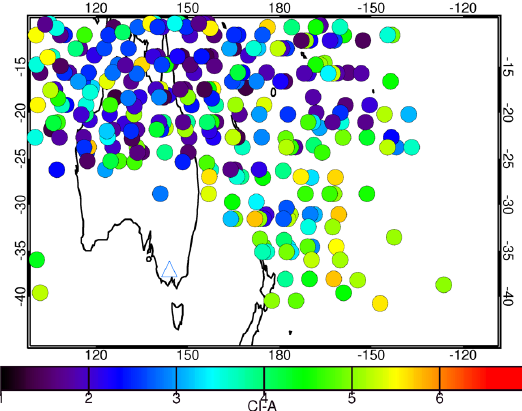
Fig. 9. Map of MIPAS CI-A between 15km and 20km for 7 Febru- ary to 16 February 2009 over Australia and New Zealand. The blue triangle indicates the position of Victoria (located at 38 ◦ S, 143 ◦ E) where the Black Saturday bushfires